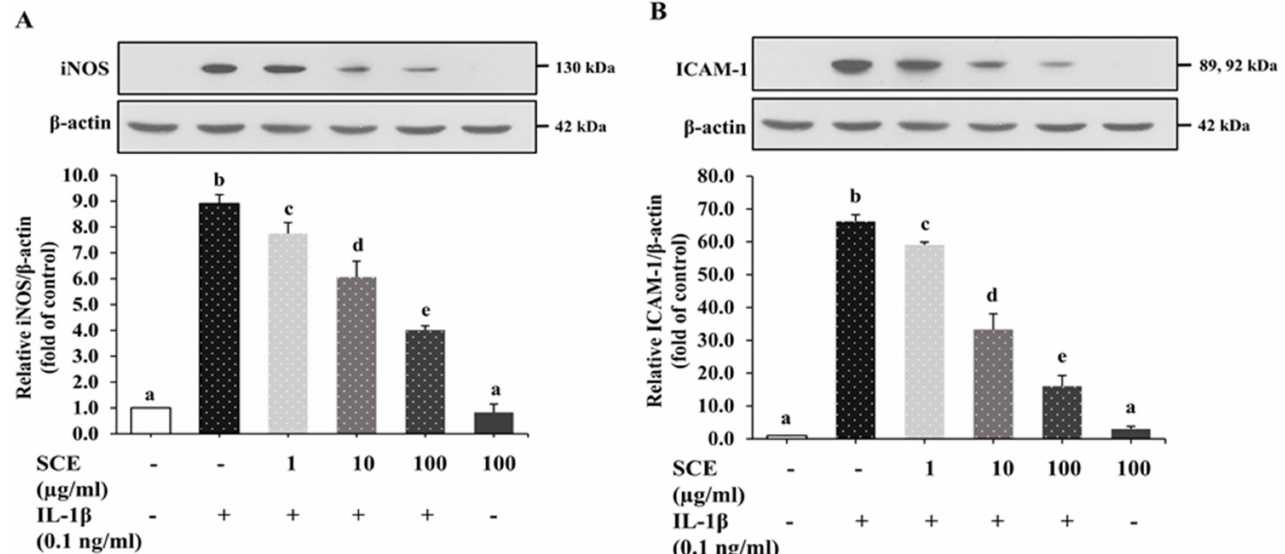
Figure 5. Effect of SCE on iNOS and ICAM-1 expression in IL-1 β -induced ARPE-19 cells. ARPE-19 cells were treated with 1–100 µ g/mL SCE for 1 h before being induced with 0.1 ng/mL IL-1 β for 24 h. The protein expressions of ( A ) iNOS and ( B ) ICAM-1 were determined using immunoblotting. Band intensities of iNOS and ICAM-1 were normalized using β -actin. Data are expressed as mean ± SD ( n = 3). The different superscripts (a–e) indicate significant differences among groups at p <